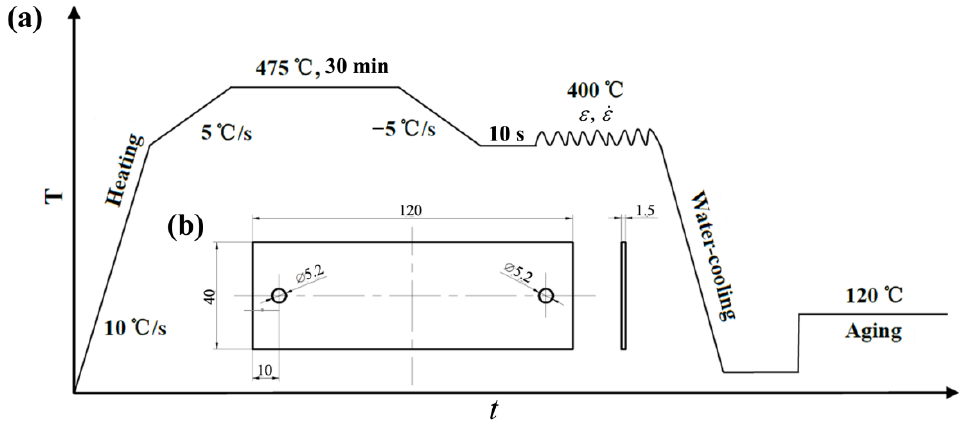
Figure 1. ( a ) Schematic diagram of thermal simulation experiment and subsequent aging process; ( b ) specimen size for thermal tensile test. ( b ) specimen size for thermal tensile test.